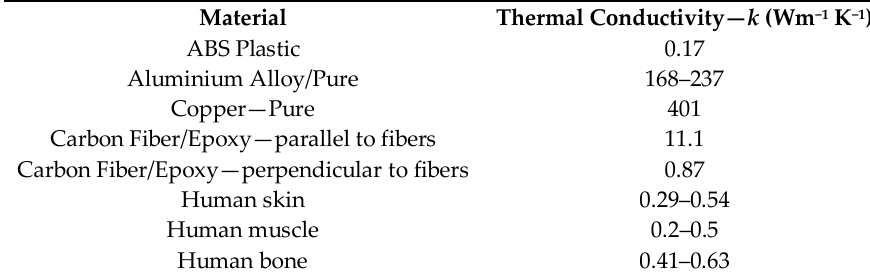
Table 1. The thermal conductivity of generic headform materials and human body parts at 300 K [7,8].